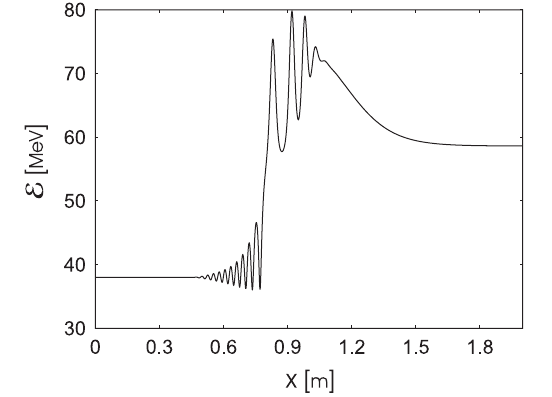
FIG. 2. The evolution of the energies of particles at the reflec- tion from the plane laser pulse with the various initial